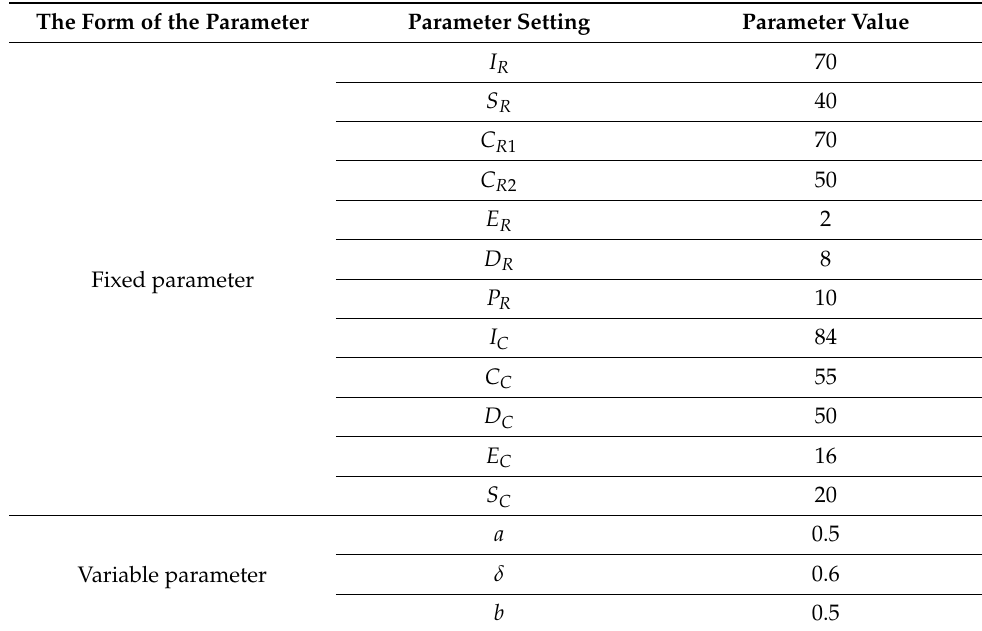
Table 13. Correlation analysis results of relevant parameters in the